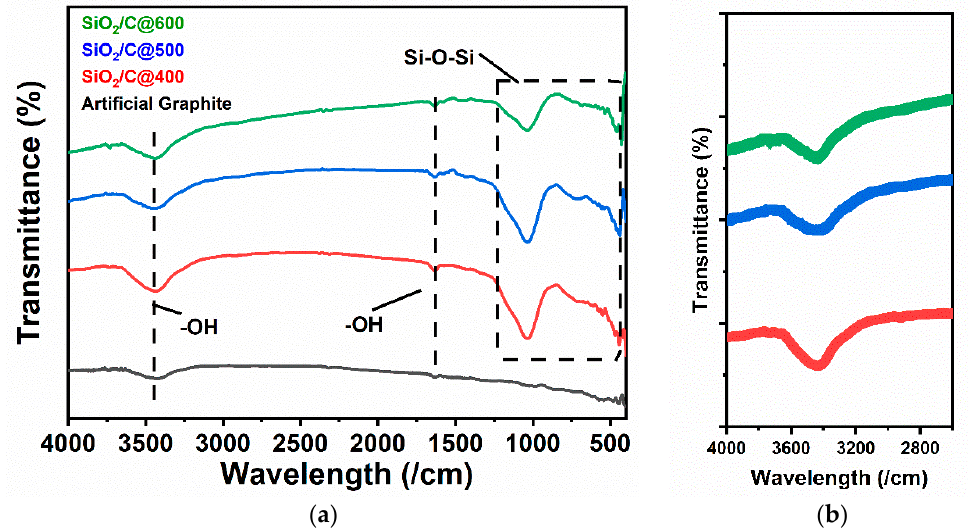
Figure 6. ( a ) FTIR spectrum of composite SiO 2 /C 10% heated at 400, 500, and 600 °C and ( b ) Magnified zone at hydroxyl peak.